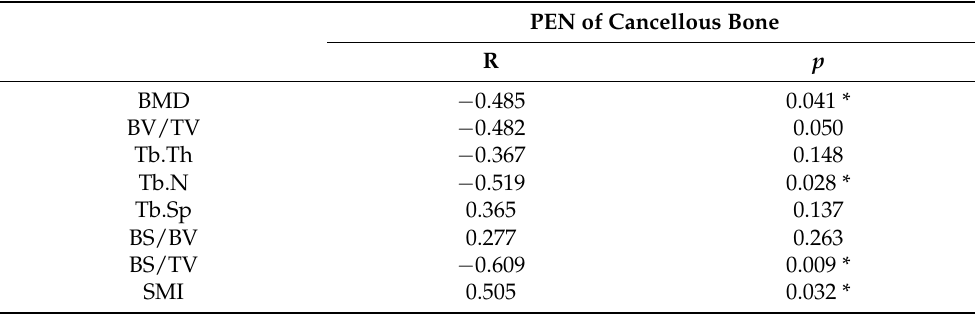
Table 1. Pearson correlation coefficient between PEN and bone microstructure parameters of cancel- lous bone (* p < 0.05).